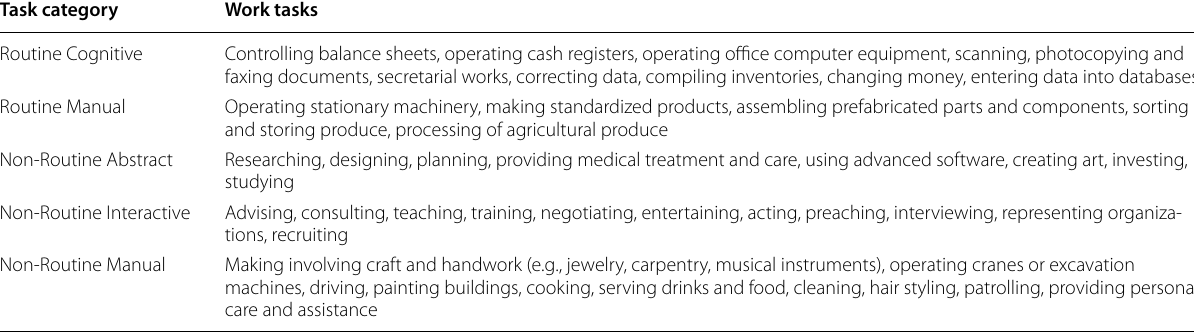
Table 6 Task Examples by Task Category